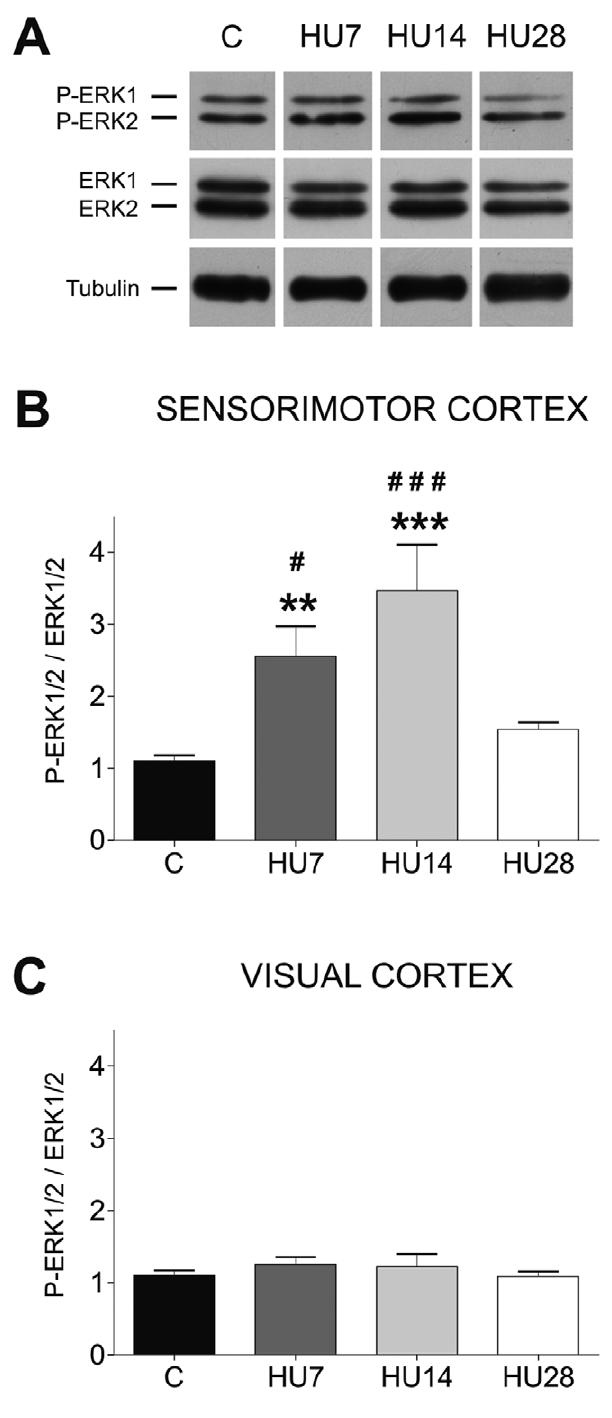
Figure 3. Hindlimb unloading transitory upregulates ERK1/2 phosphorylation in the somatosensory cortex. (A) Representative western blot showing P-ERK1/2 and total ERK1/2 immunoreactivity in the somatosensory cortex along the periods of HU. Time-course of ERK1/2 activation (ratio between P-ERK1/2 and ERK1/2) in the somatosensory cortex (B) and the visual cortex (C) after different periods of